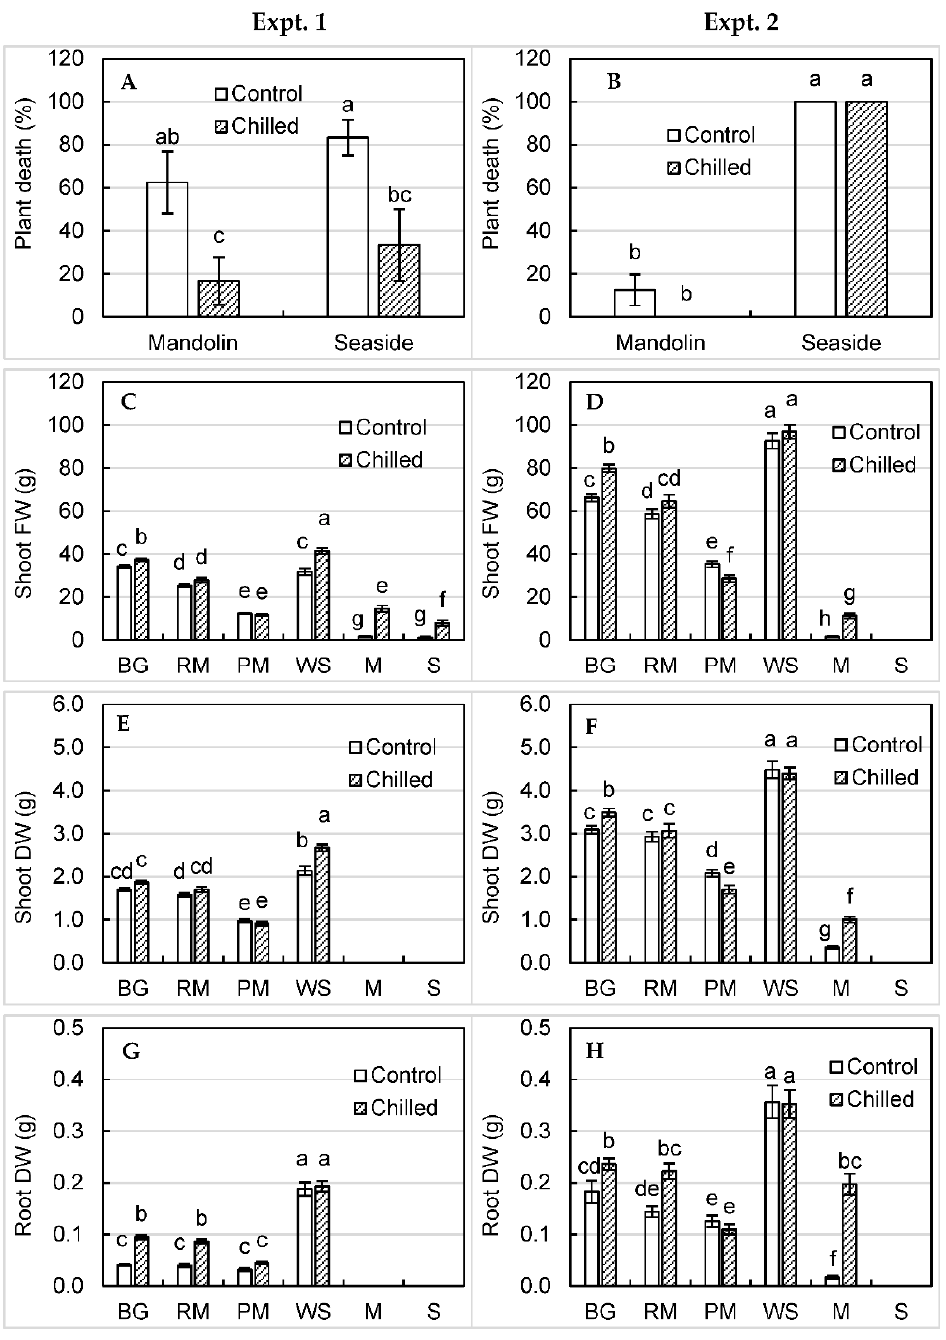
Figure 1. Plant death (mortality %) ( A , B ), shoot fresh weight (FW) ( C , D ), shoot and root dry weight (DW) ( E – H ) of the lettuce varieties ‘Bergam’s Green’(BG) and ‘Red Mist’ (RM), Pak Choi varieties ‘Purple Magic’ (PM) and ‘White Stem’ (WS), and spinach ( Spinacia oleracea L.) ‘Mandolin’(M) and ‘Seaside’ (S) grown in a deep-water culture hydroponic system with nutrient cooling or no cooling (Control). All growth data units from ( C – H ) are g/plant. Different letters represent significant differences between treatments according to Tukey’s HSD test ( p <